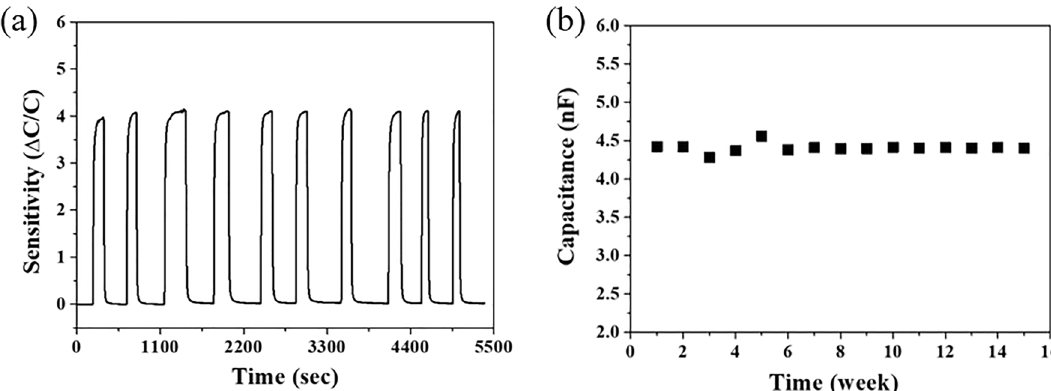
Figure 7. ( a ) The repeated humidity sensing test of 10 cycles at a frequency of 100 kHz for 71.4% RH, and ( b ) long-term stability test of the capacitance as a function of time for humidity sensing at the frequency of 100 kHz for 53.4%